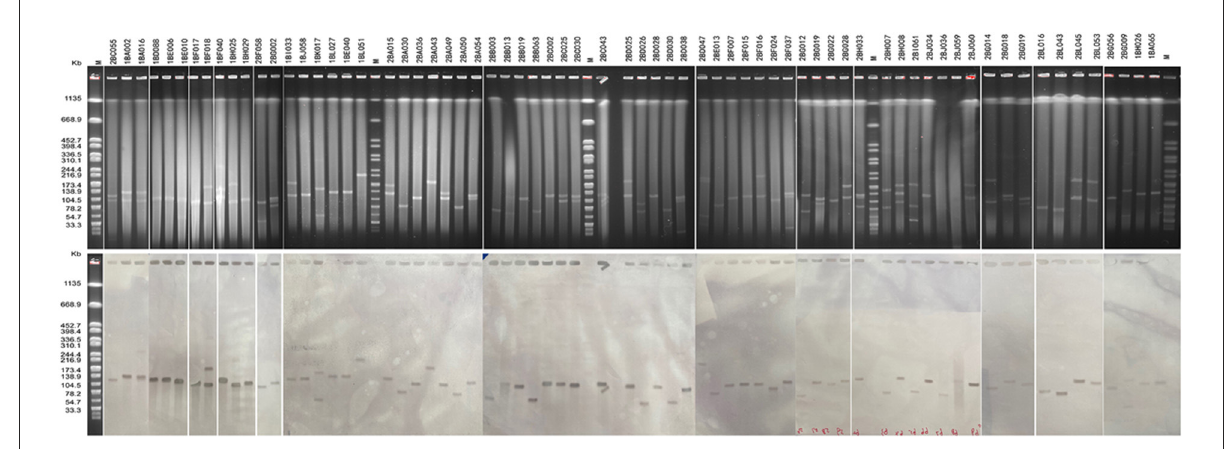
FIGURE4 S1-PFGE analysis of bla CTX − M − 3 -positive K. pneumoniae isolates and southern hybridization. Lane M, Salmonella Braenderup H9812 as molecular weight